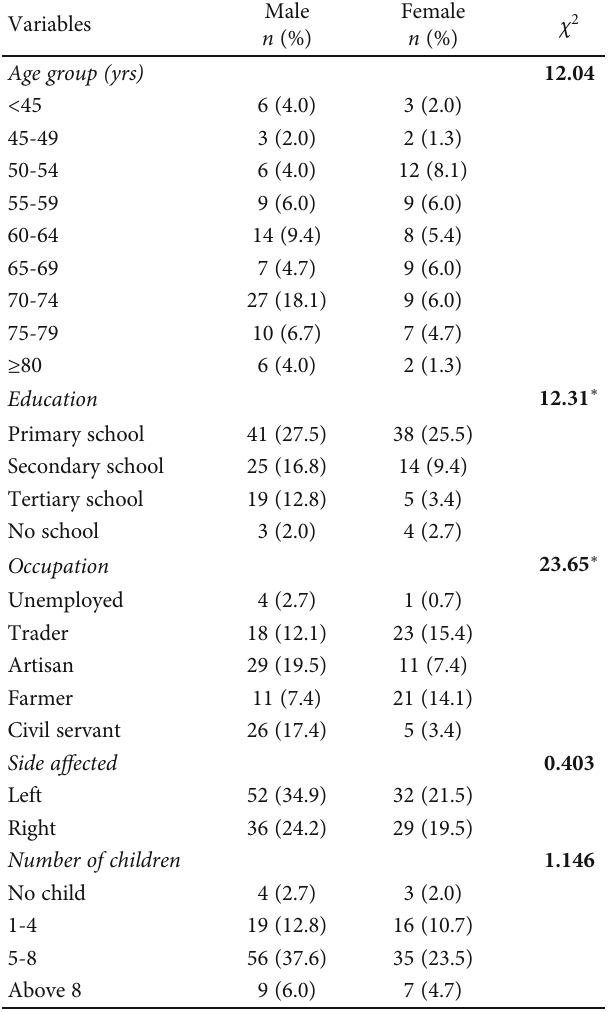
Table 1: Descriptive characteristics of the survivors and Person ’ s chi-square test between male and